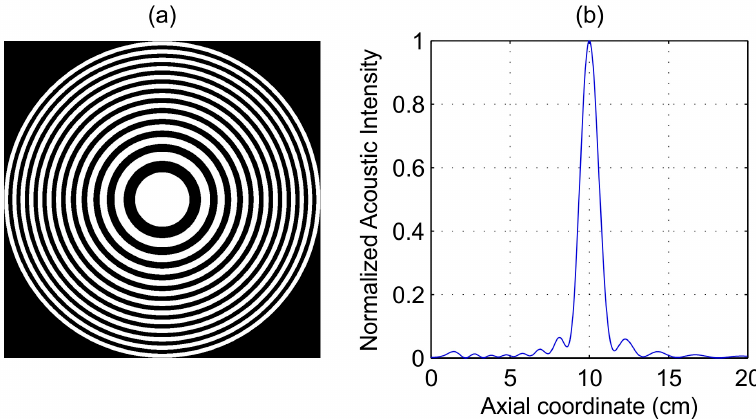
Figure 1. ( a ) Fresnel Zone Plate (FZP) layout; ( b ) Simulated acoustic intensity against axial distance.